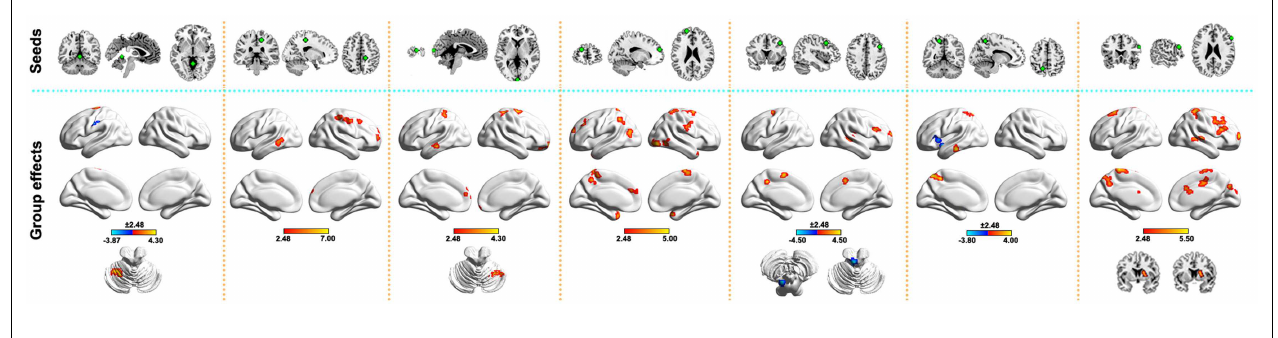
functional connectivity in the PD (bottom row) were mapped onto the brain surface using the BrainNet viewer (http://www.nitrc.org/ projects/bnv/). SeeTable S1 in Supplementary Material for detailed